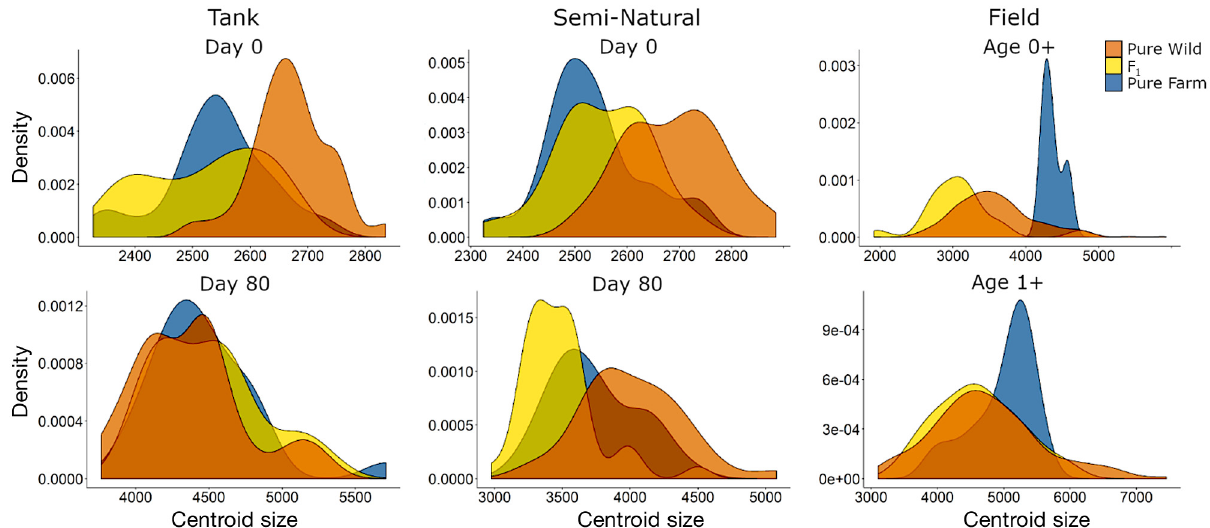
Fig. 5. Centroid sizes of juvenile salmon calculated using 19 landmarks for each sample (see Fig. 1b). The y -axis represents the distribution of individuals for each group of that size. Measurements for the common garden experiment were taken on Day 0 (start) and Day 80 (end) post yolk absorption. Juveniles aged 0+ and 1+ were sampled from southern Newfoundland rivers (Fig. 1a, Table S1). Field-captured/collected pure farm salmon aged 0+ have a small sample size and were not evaluated sta- tistically, but are presented for completeness. Identification of cross type of field-sampled individuals was accomplished using genetic assignment and is described in Section